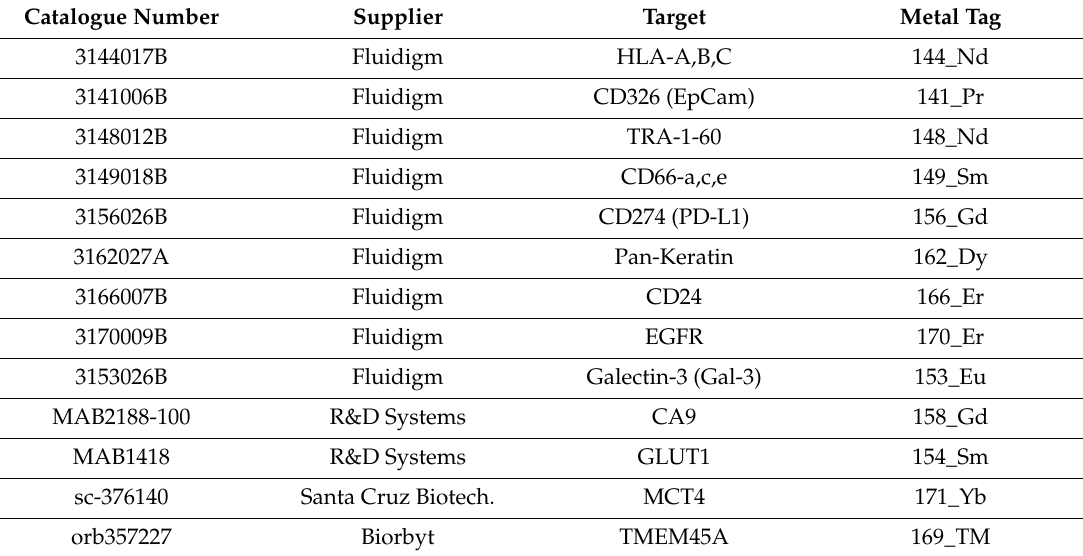
Table 1. Antibodies used for mass